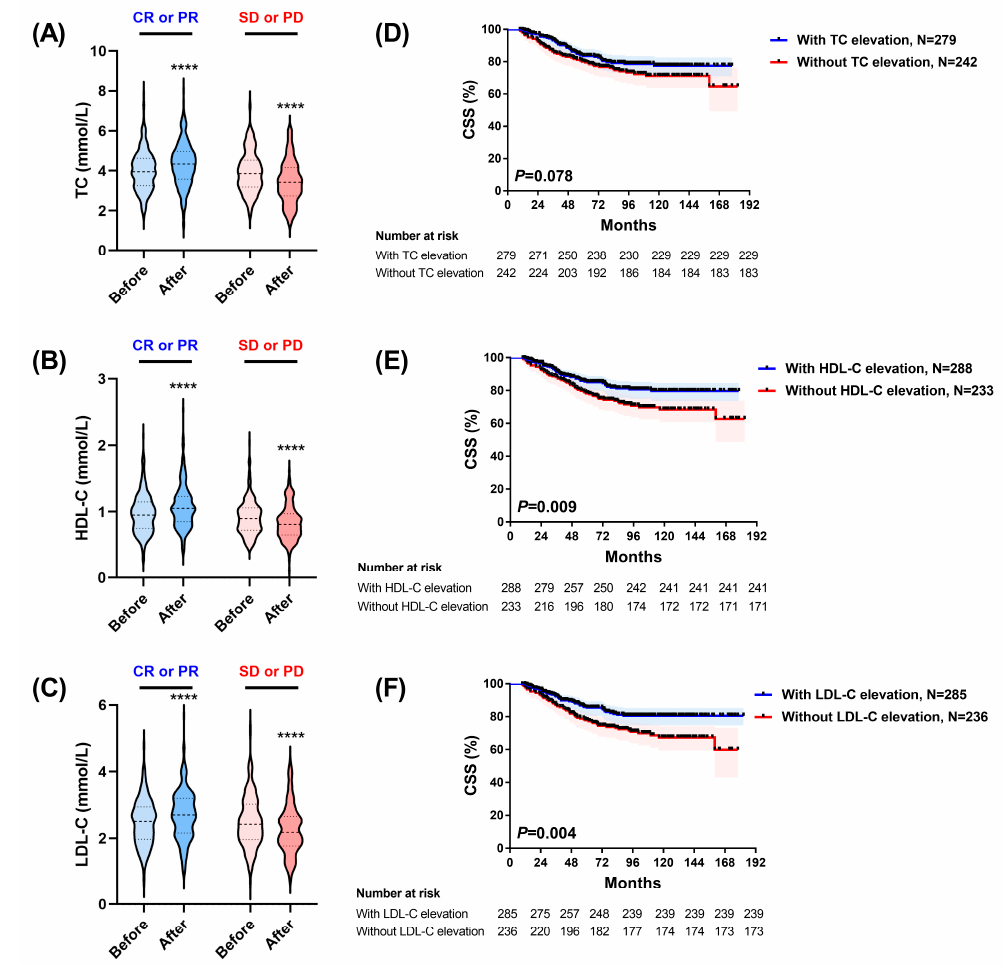
Figure 2. Post-chemoimmunotherapeutic cholesterol fluctuation in relation to treatment response and prognosis. ( A – C ) Pre- and post-therapeutic levels of total cholesterol (TC) ( A ), high-density lipoprotein cholesterol (HDL-C), ( B ) and low-density lipoprotein cholesterol (LDL-C) ( C ) in patients with complete remission (CR) or partial remission (PR) and stable disease (SD) or progressive disease (PD). ( D – F ) Comparison of survival between patients with and without TC ( D ), HDL-C ( E ), or LDL-C ( F ) elevation after completion of therapies. Abbreviations: TTFT: time to first treatment; CSS: cancer-specific survival. **** p -value < 0.0001.